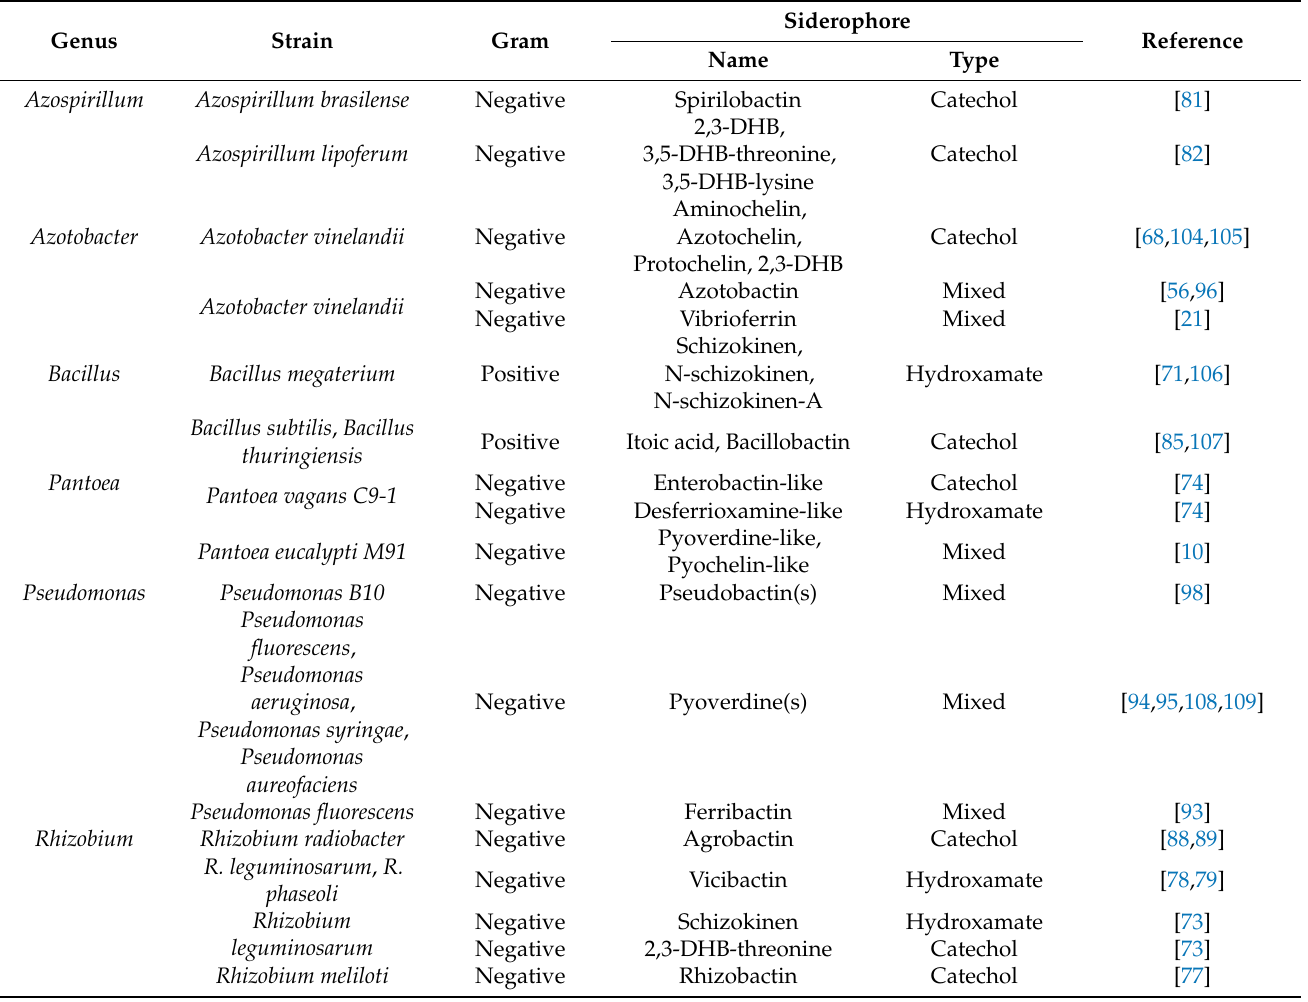
Table 1. Major siderophore-producing PGPB for which the siderophore structure has been